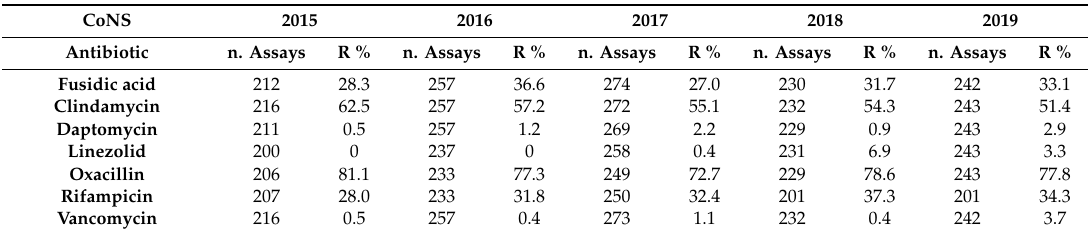
Table 3. Antimicrobial resistance profile of CoNS strains from patients with BSI to commonly used antibiotics.